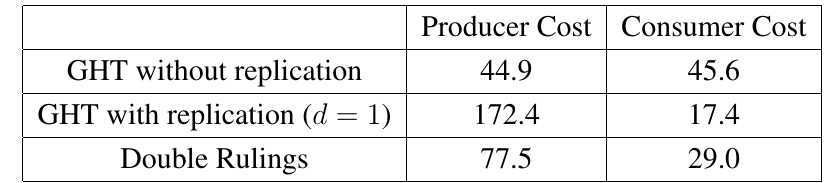
Table 2. Average producer and consumer costs in hop numbers for GHT, multi-replication GHT and Double